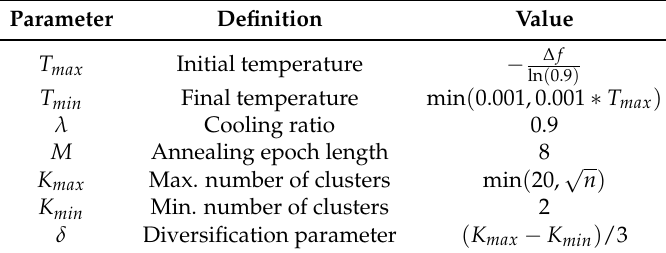
Table 2. Parameter